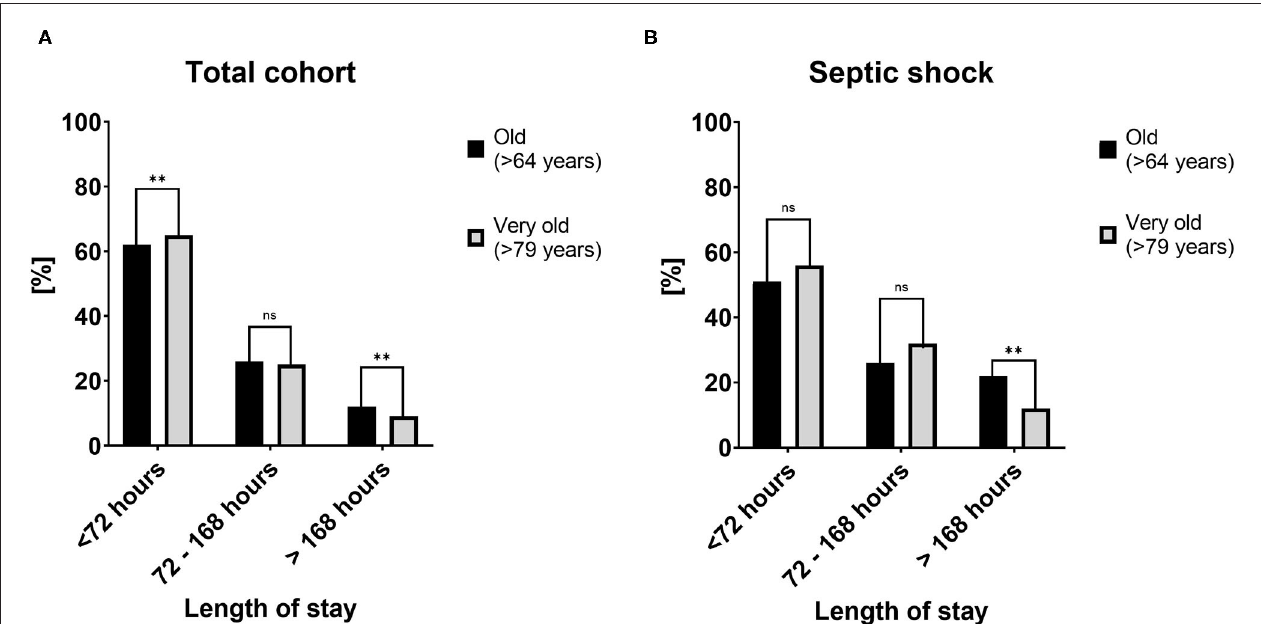
FIGURE 2 | Length of stay in the total cohort (A) and the subgroup of patients with septic shock (B) stratified for length of stay categories into < 72, 72–168, and > 168h. [%] ** p < 0.01.